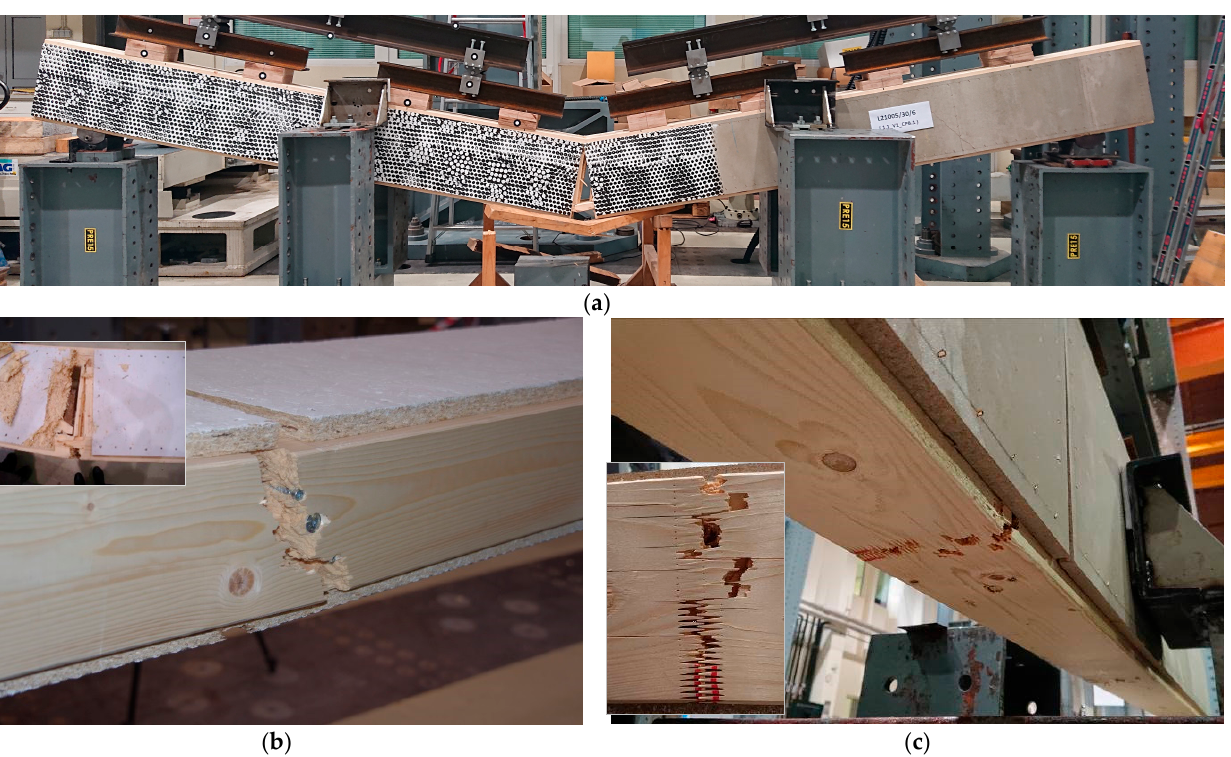
Figure 8. Typical failure and damage mechanisms of beams with no web panels: ( a ) Failure of the bottom flange at vertical stud–flange joint and large deformations of the vertical stud–flange joints; ( b ) Shear failure of the upper flange at vertical stud–flange joint and large deformations of the ver- tical stud–flange joints.